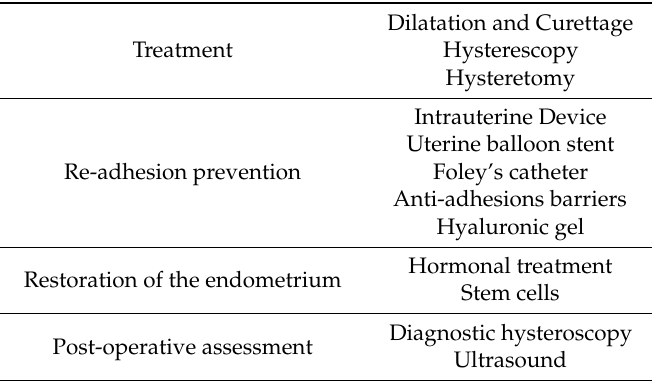
Table 5. Approaches dedicated to treating the Ahserman